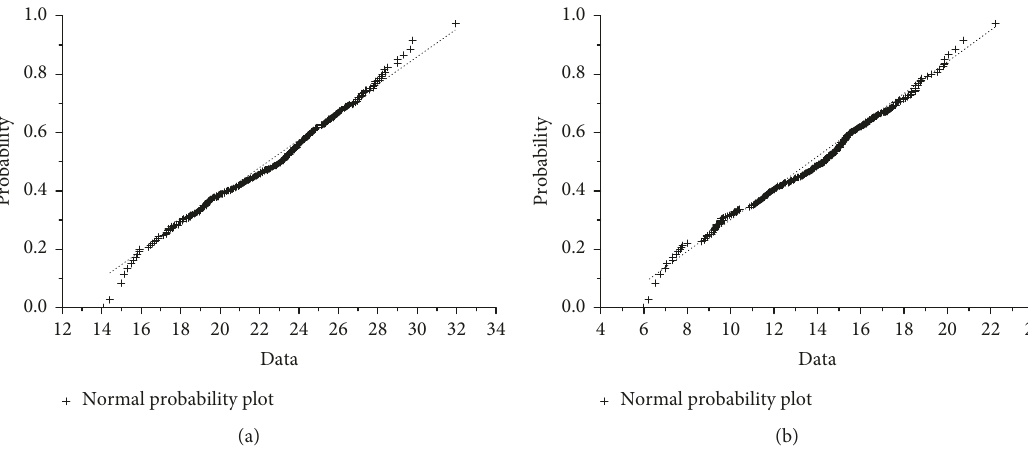
Figure 9: The distribution probability diagram of the daily extreme value of axial uniform temperature in November. (a) The maximum. (b) The